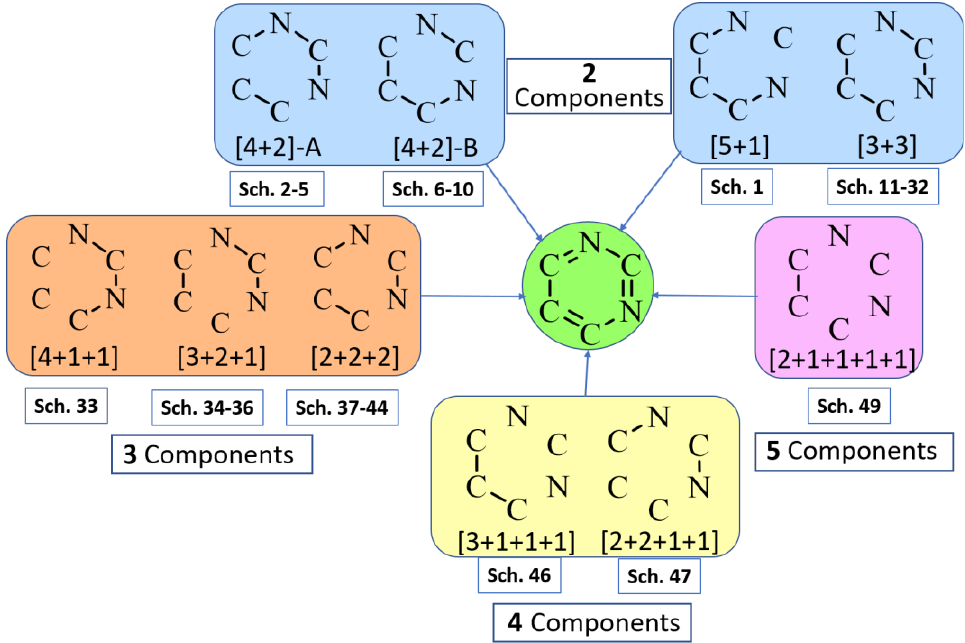
Figure 1. Formation of pyrimidine core from diverse numbers of components.